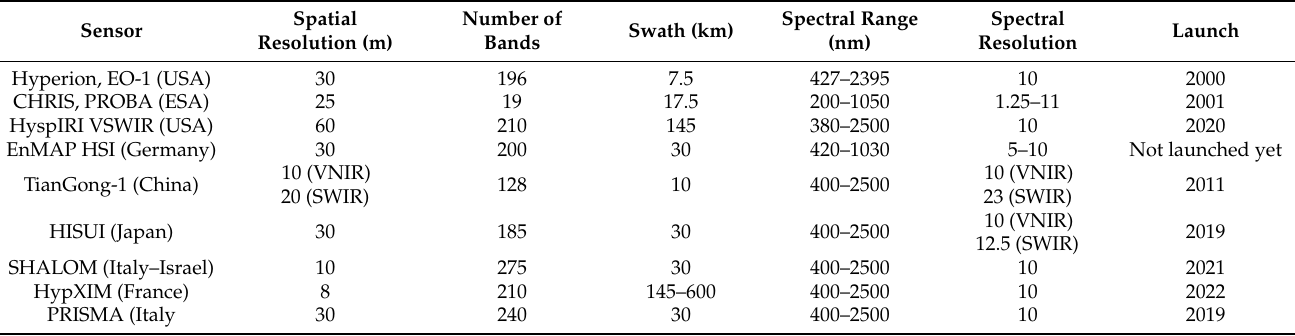
Table 1. Main characteristics of spaceborne hyperspectral